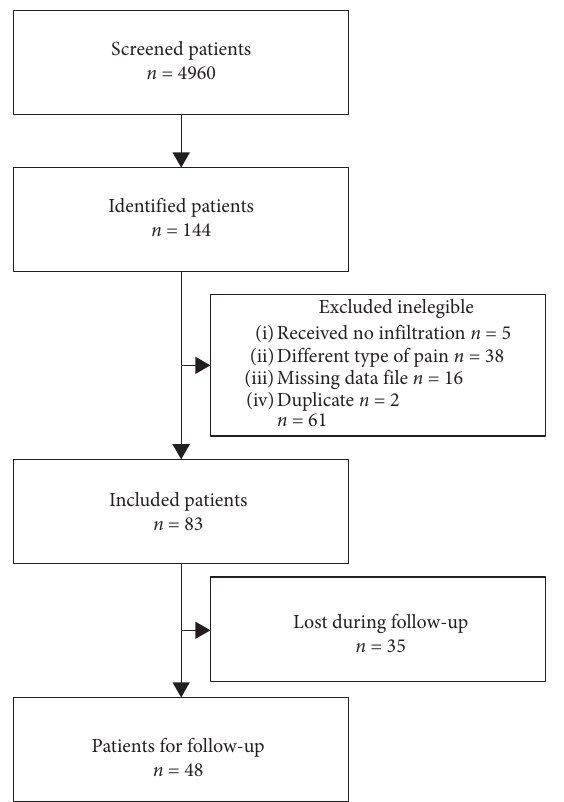
Figure 1: STROBE chart indicating the process of patient re- cruitment for this retrospective